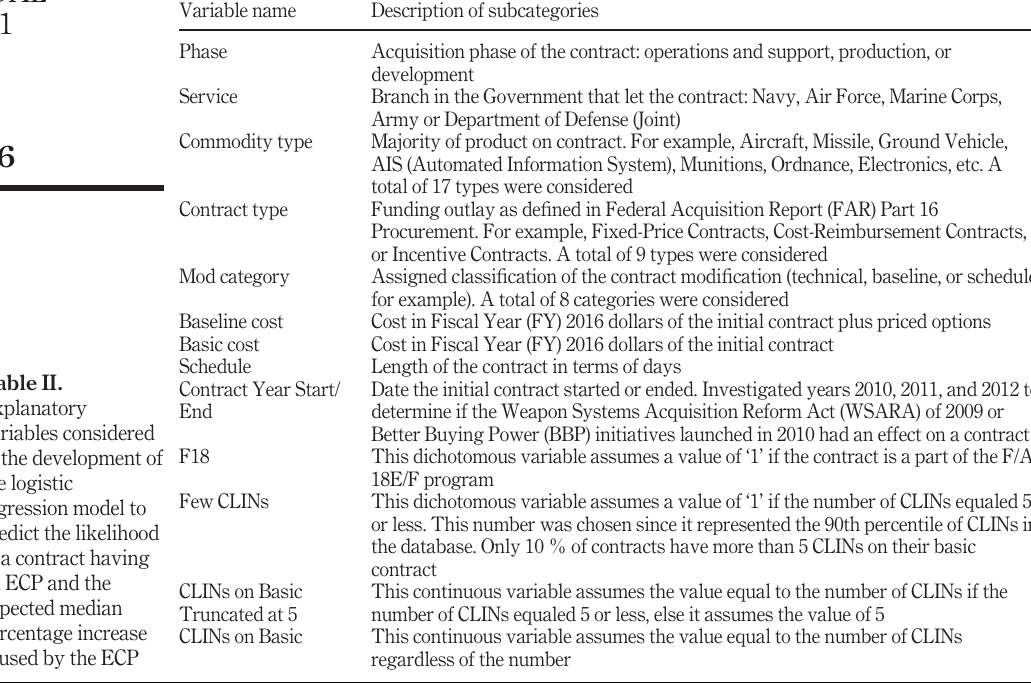
model validation. For the OLS model, approximately 20 per cent of the contracts that